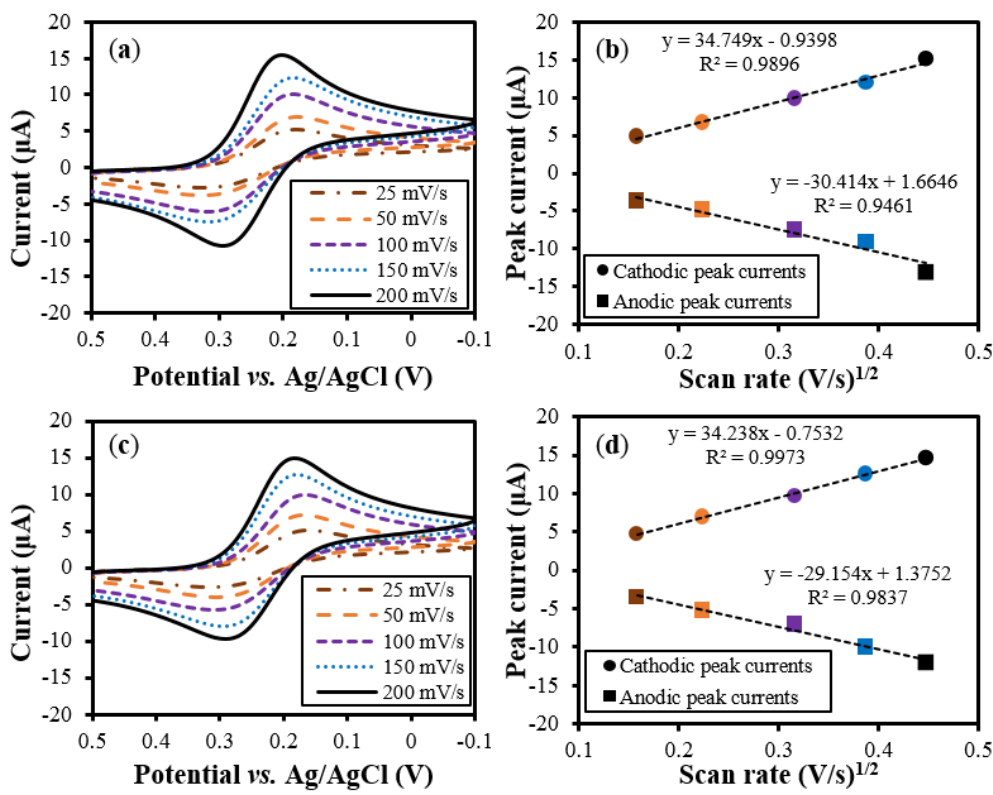
Figure 7. Comparison of the CV curves of the ORE and SSRE for scan rates of 25, 50, 100, 150 and 200 mV/s. ( a ) and ( b ) are the CV curves for the ORE (plotted for comparison), and ( c ) and ( d ) are the curves for the SSRE. The solid circles (●) and boxes (■) in ( b ) and ( d ) stand for the cathodic and anodic peak currents, respectively. (The measurements were made three times. The error bars for the values were not shown as the difference in the currents was smaller than 0.5